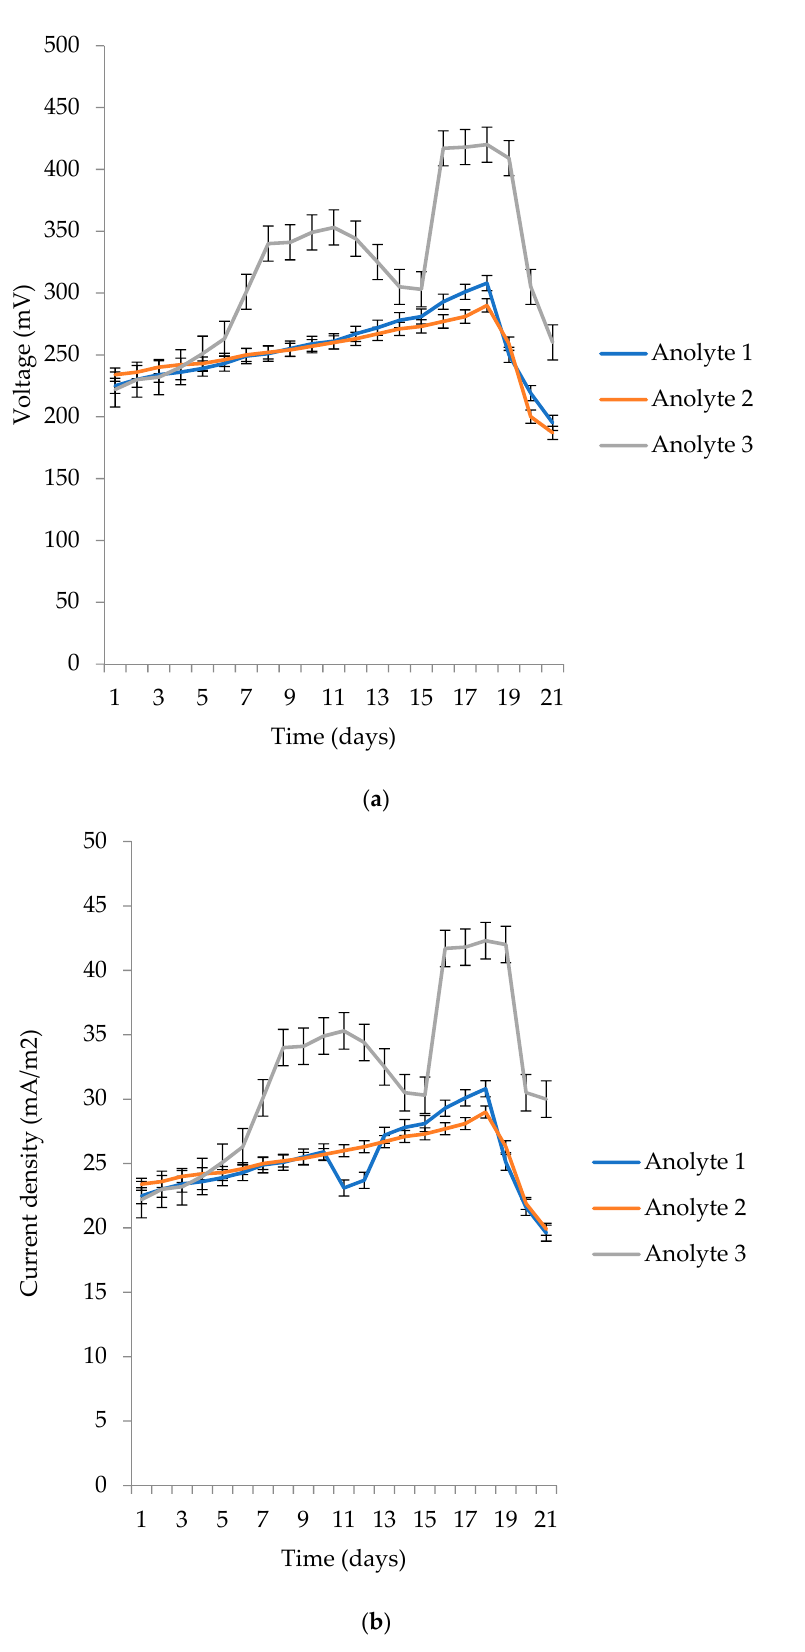
Figure 4. Voltage ( a ) and current ( b ) generation in a single MFC of poultry wastewater in the single-chamber MFC for 21